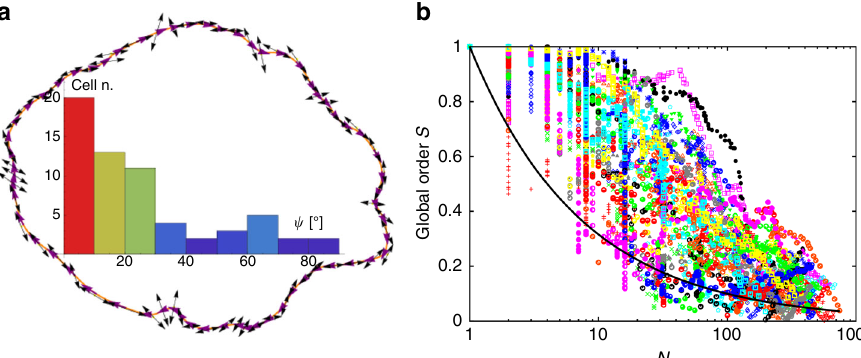
Fig. 3 Active anchoring and global order. a Bézier curve constructed through the centroids of the bacteria at the boundary of a typical colony. Inside, the histogram of the (acute) angle ψ i between the boundary tangent and bacteria directors ν (black arrows). Most cells tend to align with the tangent of the colony boundary. b Plot of the global order, S , as a function of colony size for 32 colonies. The continuous curve is S ¼ 1 =